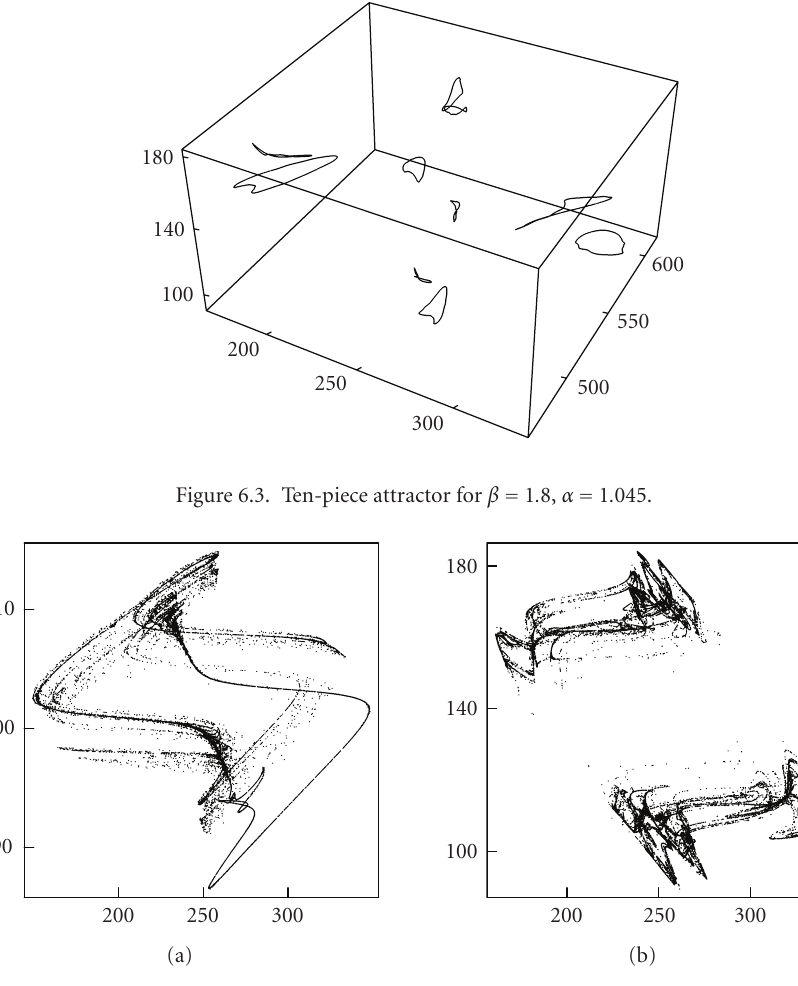
Figure 6.4. (a) Chaotic attractor for β = 0 . 5, α = 1 . 9; (b) two-piece chaotic attractor for β = 1 . 8, α = 1 . 15. Projections in the Y - M plane.